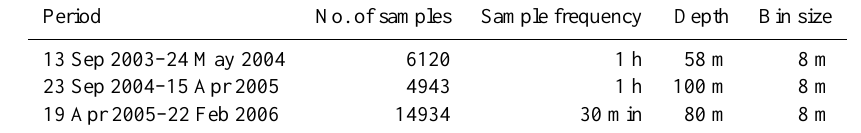
Table 1. Experimental configuration of the ADCP during the three deployments, from September 2003 to February 2006. Period No. of samples